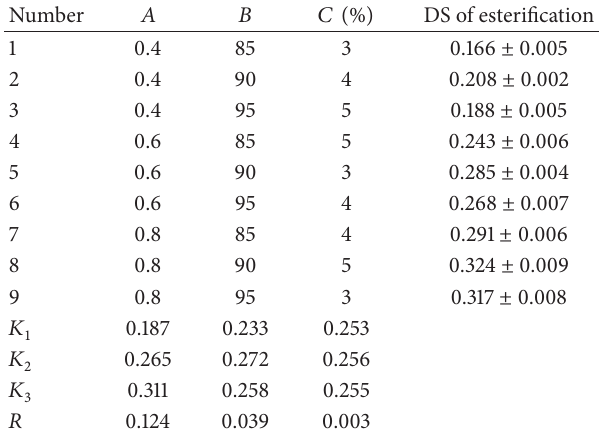
Table 3: The optimization process for esterification process.